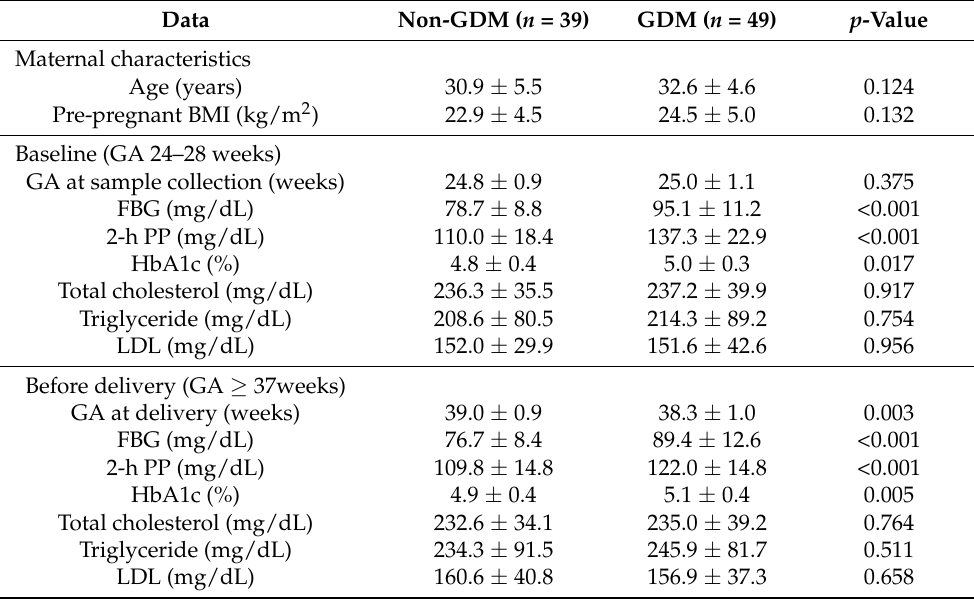
Table 2. Clinical characteristics and metabolic